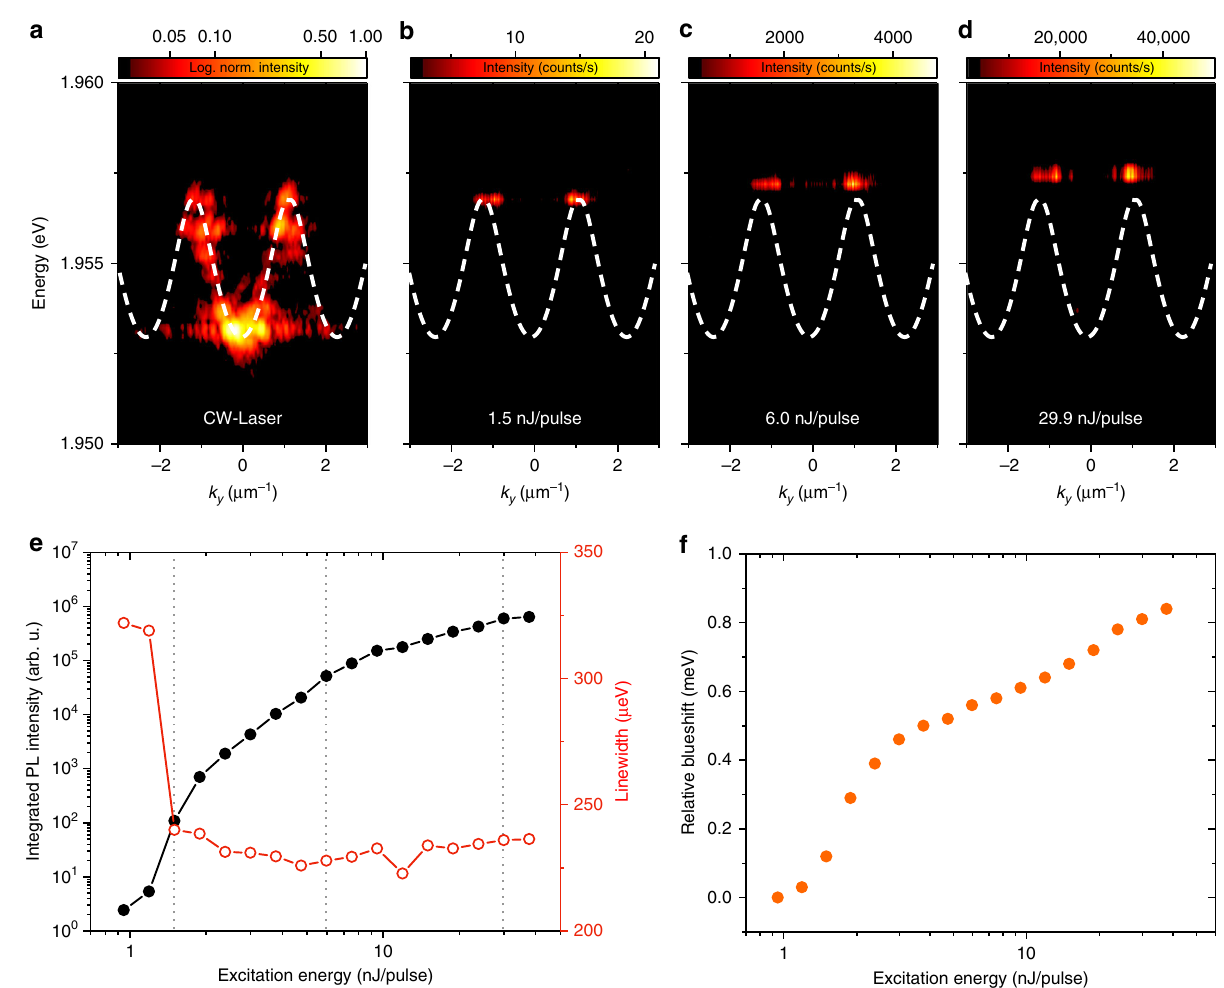
Fig. 2 Excitation power-dependent analysis of an one-dimensional lattice. a – d Far- fi eld photoluminescence spectra recorded at various pump powers. Excitation with a continuous-wave laser ( a ), the white line shows calculated single-particle energy s-band in the effective periodic potential. Angled- resolved spectra for pump powers at the condensation threshold ( b P = 1.5 nJ/pulse), above the threshold ( c P = 6.0 nJ/pulse), and far above the threshold ( d P = 29.9 nJ/pulse). The condensed mode moves into the gap. e Integrated emission intensity (black) and linewidth (red) versus excitation energy. At P = 1.5 nJ/pulse, the linewidth drops to the resolution limit of the spectrometer, whereas the intensity clearly features a superlinear increase. f Excitation power-dependent blueshift of the